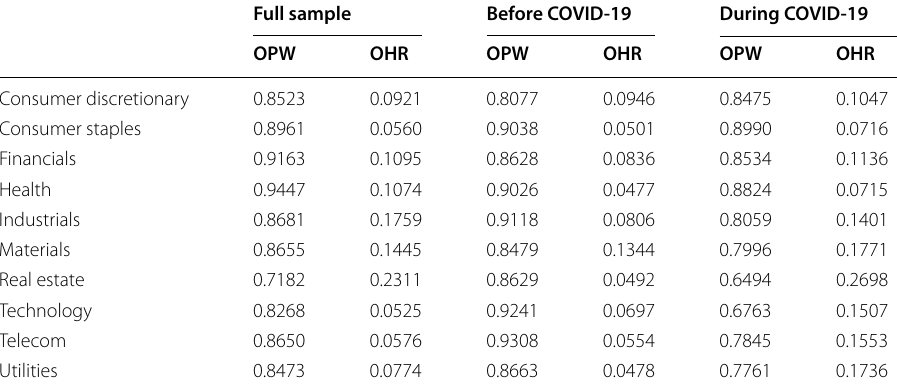
Table 7 Optimal portfolio weights and hedge ratios using breaks adjusted